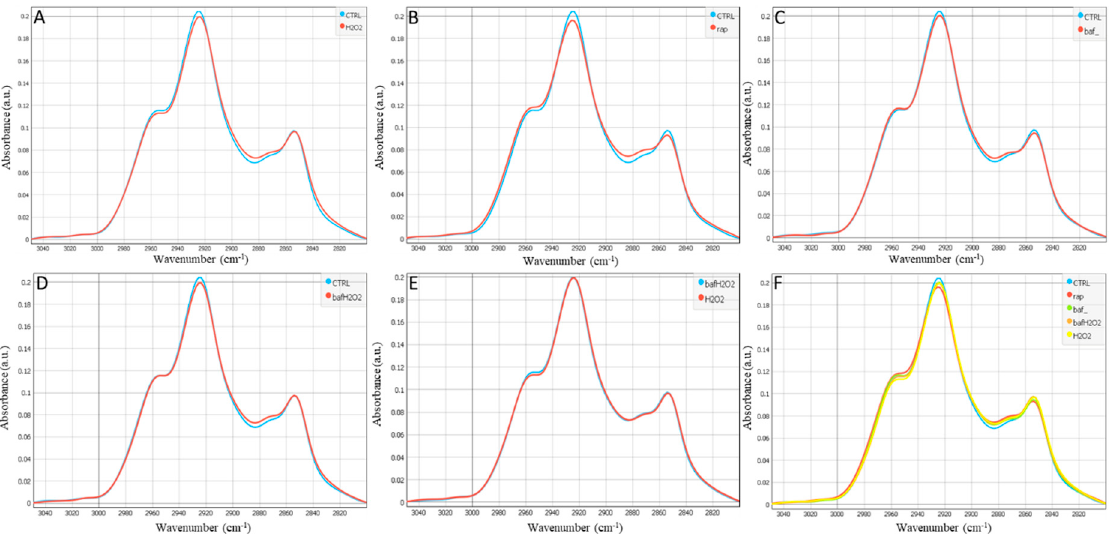
Figure 3. Average spectra of the lipid region (2800–3050 cm -1 ) in hRPEs: ( A ) Control vs. H 2 O 2 , ( B ) Control vs. Rap, ( C ) Control vs. Baf, ( D ) Control vs. Baf+H 2 O 2 , ( E ) Baf+H 2 O 2 vs. H 2 O 2 , and ( F ) all conditions are being shown. Representative data of a number of cells per condition (N = 35–37 cells).